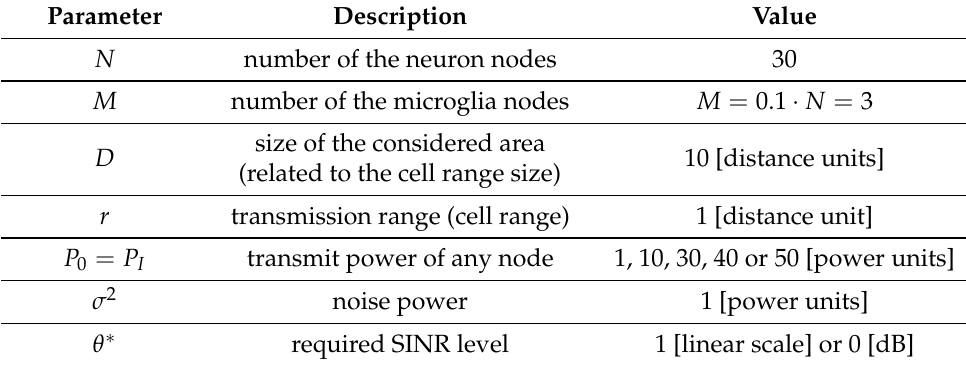
Table 1. Simulation parameters used in the first phase of the